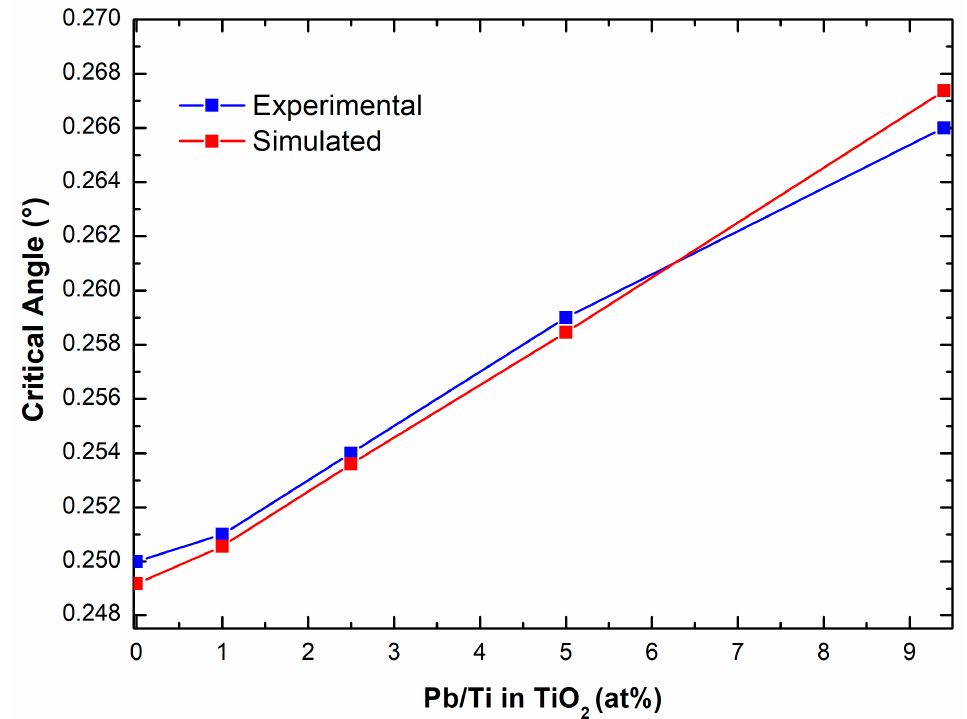
Figure 4. Raising of the critical angle of TiO 2 for soaking at increasing lead concentrations in the solution: experimental and calculated values. Table 2. Atomic percentage of Pb/Ti in Pb X Ti (1 − x) O 2 with respective critical angles. Pb/Ti in TiO 2 (at%)